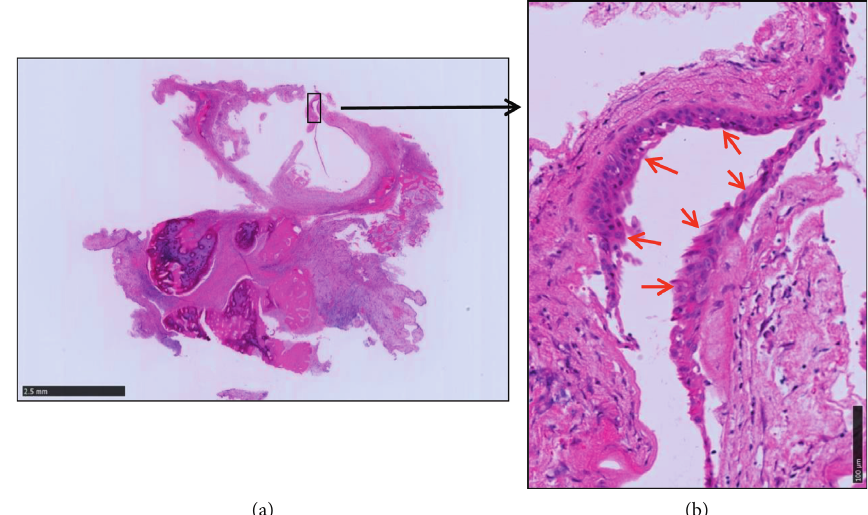
Figure 5: Hematoxylin and eosin staining. (a) Magnifying glass image and (b) 200 × magnification. The cyst displays fibrous walls with squamous metaplasia of the ciliated pseudostratified epithelium due to chronic inflammation (red